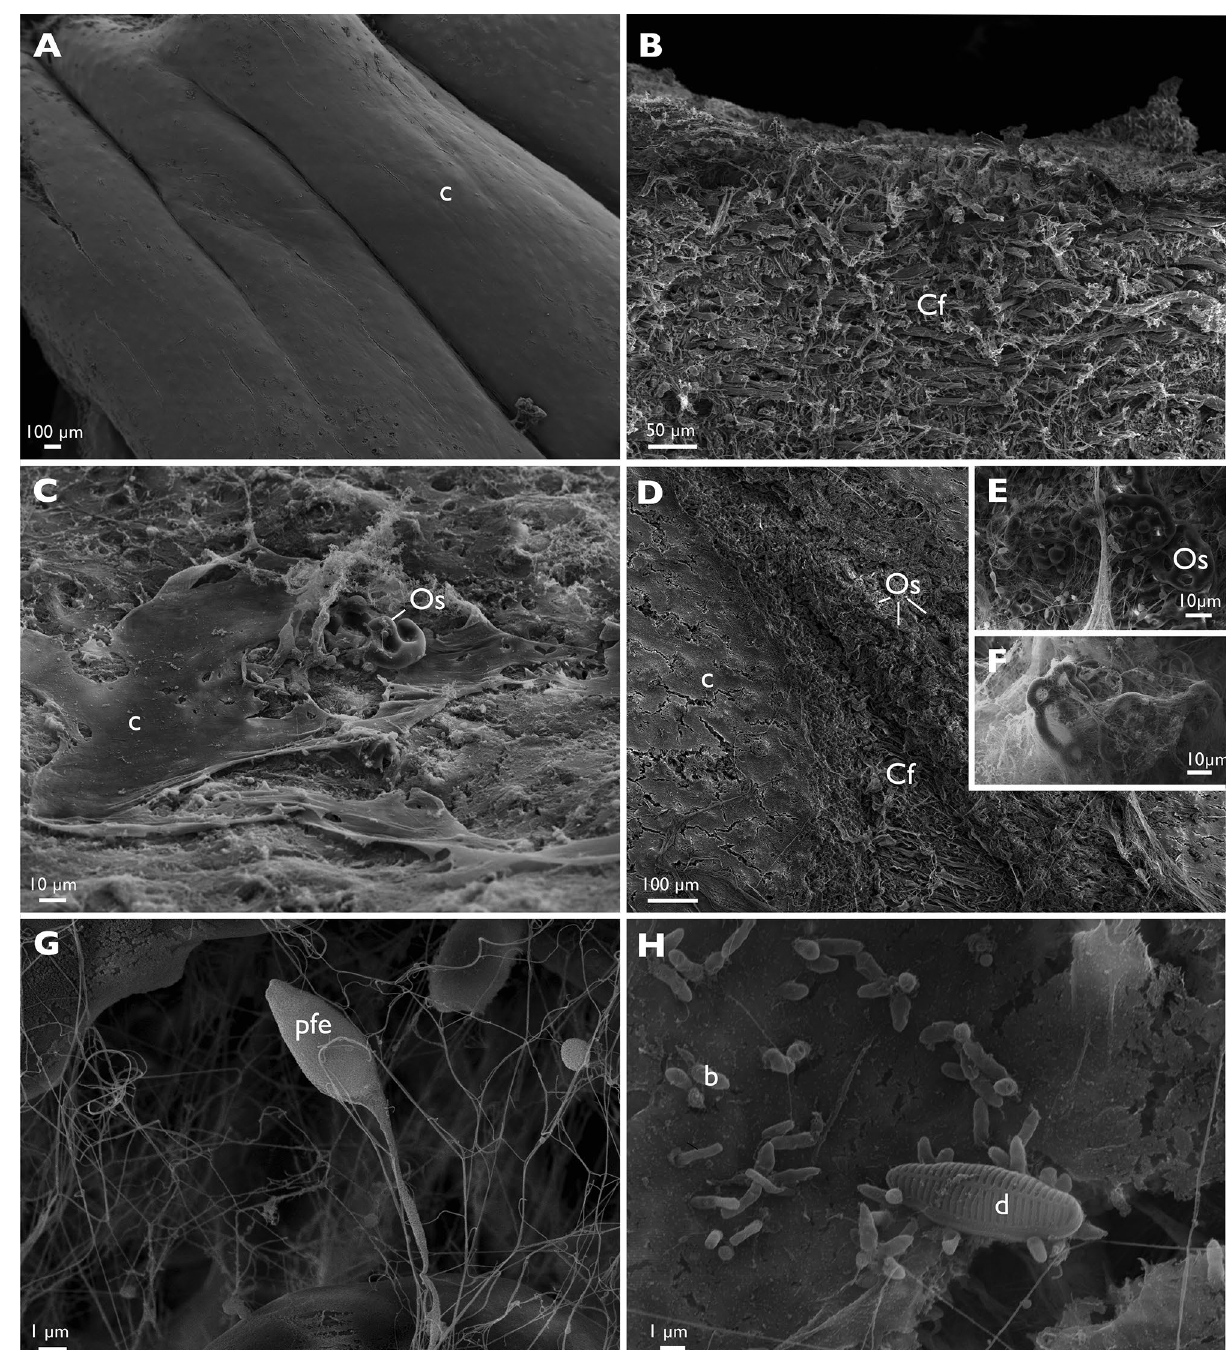
Figure 5. The fine external structure of healthy and SKUD-affected Holothuria scabra sea cucumber integument. ( A , B ) healthy integument, ( A ) external surface of the integument, ( B ) connective tissue present under the epidermis (transverse section). ( C – H ) SKUD-affected integument. ( C – H ) external surface of the ulcerated integument. ( E – H ) Ossicles, bacteria and diatoms visible at the ulcer surface. Legend: b bacteria, c cuticle, Cf collagen fiber, d diatom, pfe predicted flagellated eukaryotes, Os